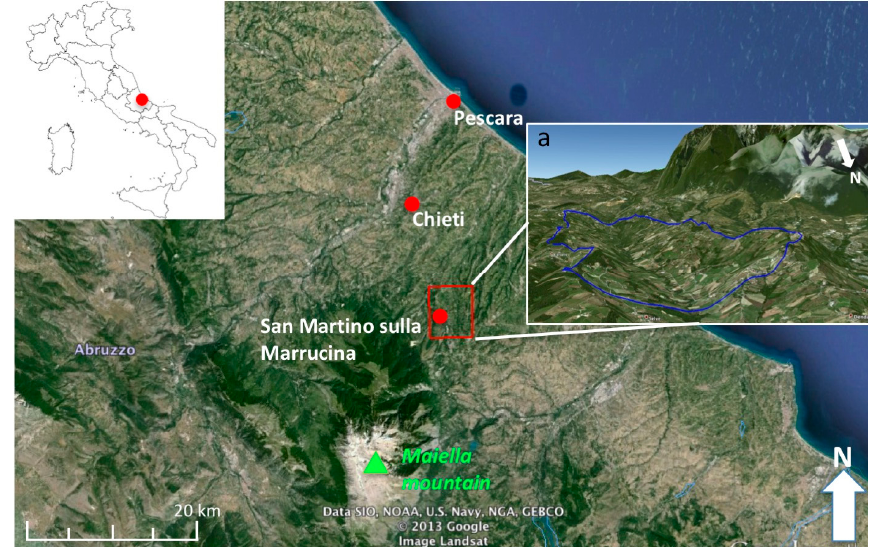
Figure 1. Location of the study area. The red box identifies the study area. ( a ) A 3D image shows the watershed (blue line) bounding the basin under investigation. The images are extracted from Google Earth ® .